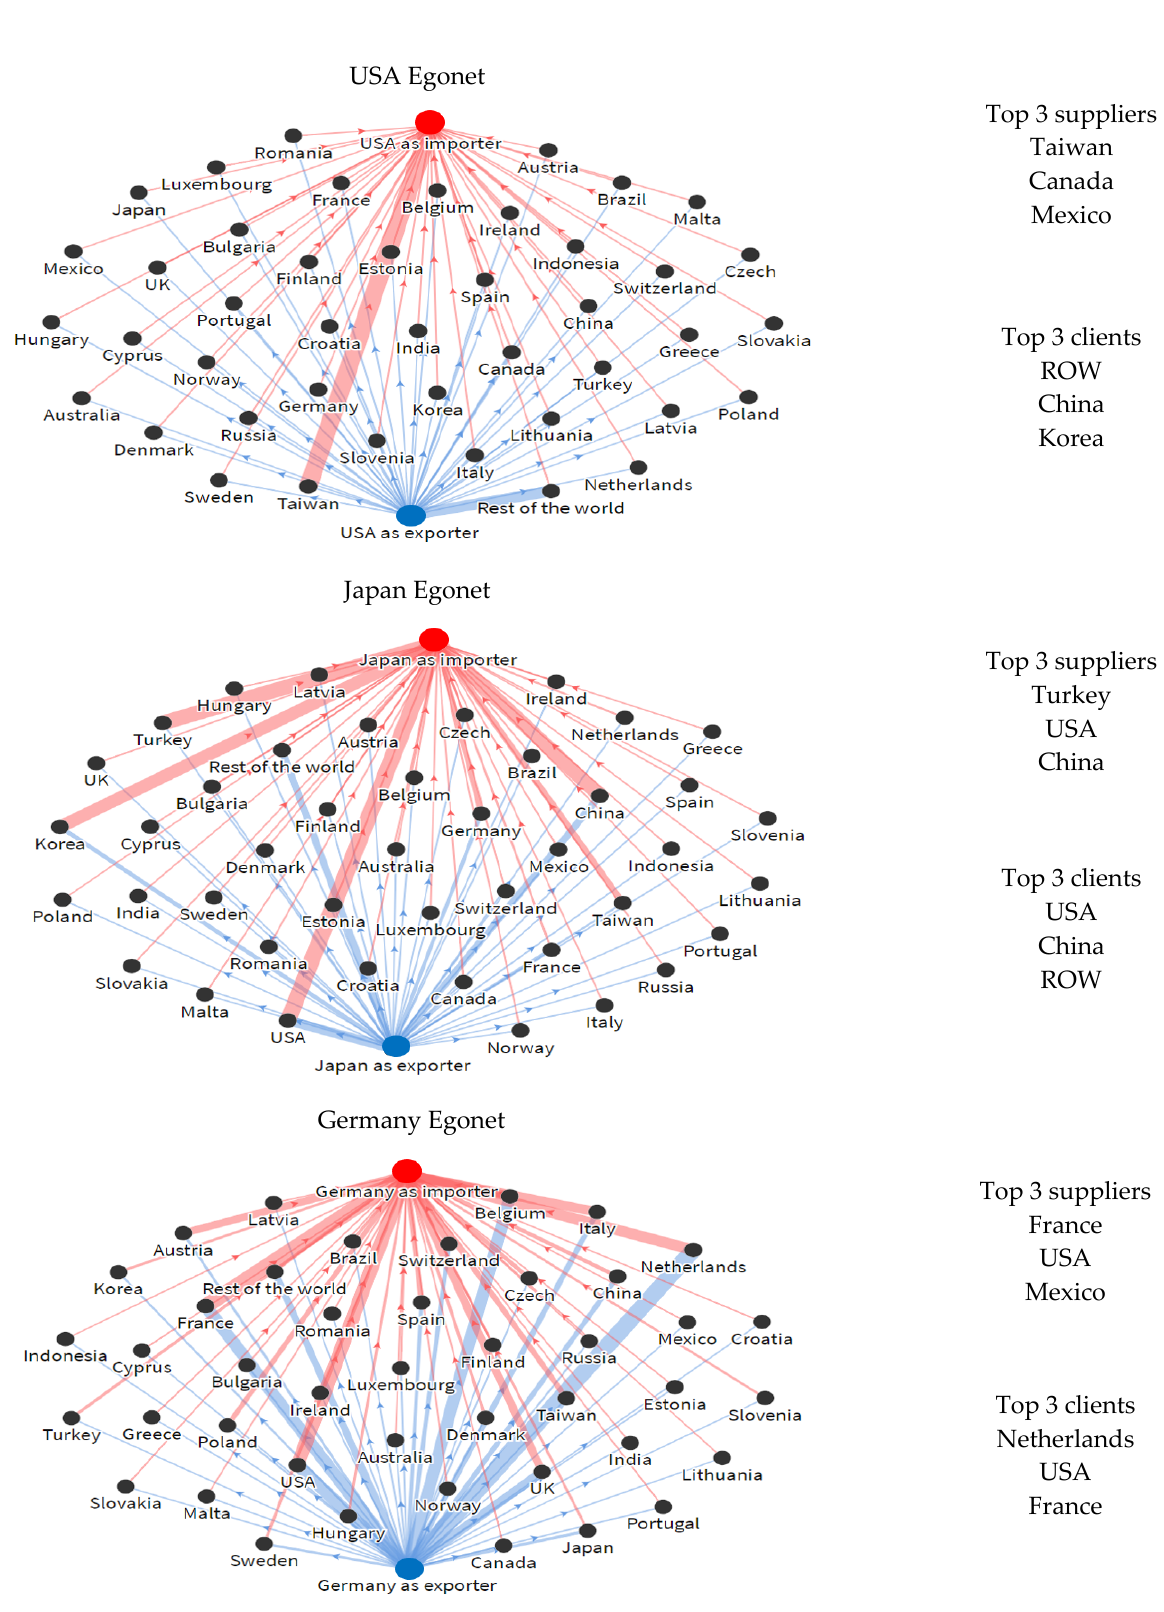
Figure 8. The egonets of USA, Japan, and Germany in the Sectoral GVC network: “Manufacture of chemicals and chemical products”.